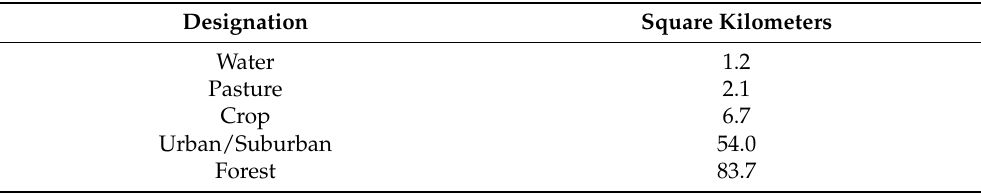
Table 1. General Land-Use Designations for South River Watershed.